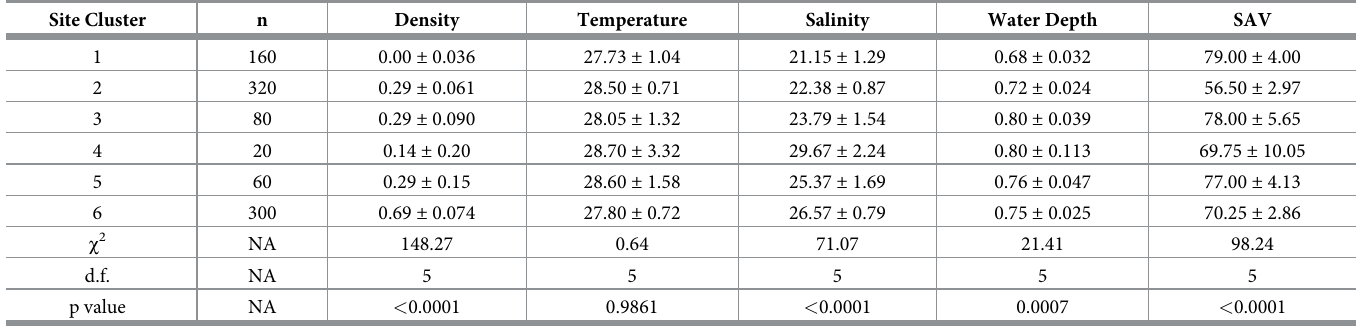
Table 5. Median and ~95% CI of density (shrimp m -2 : LN([x+1]), temperature (˚C), salinity (ppt), water depth (m), and submerged aquatic vegetation (SAV: % cover) and the χ 2 , d.f., and p values associated with Kruskal-Wallis testing of density clusters relative to